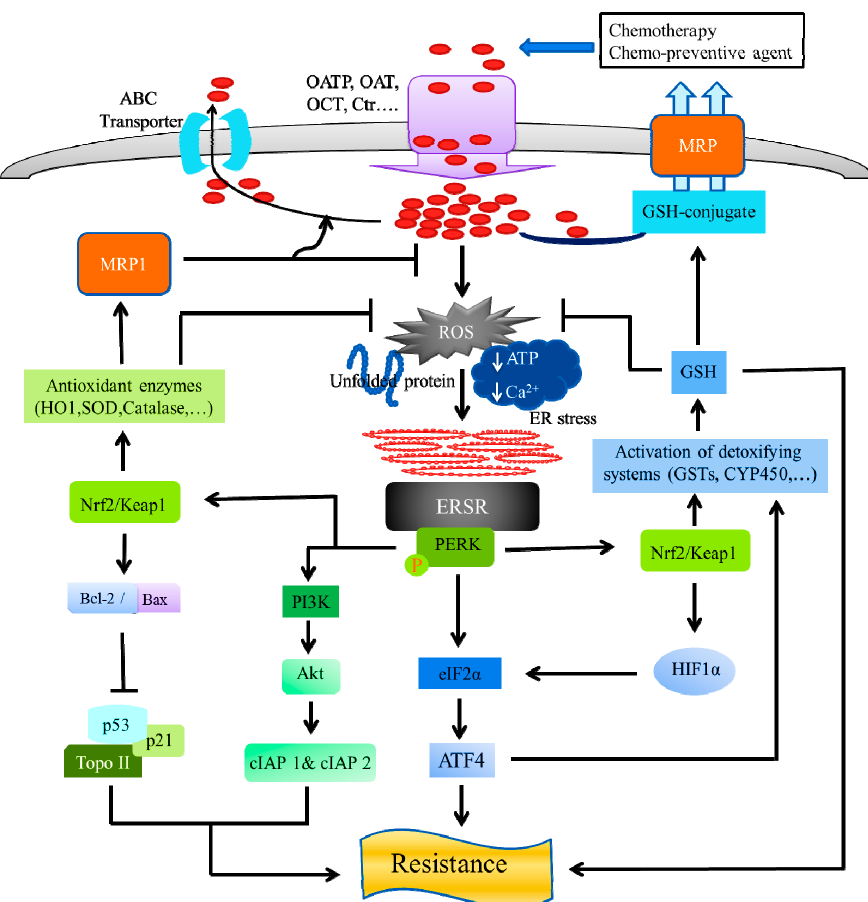
Figure 3. ER stress and chemo-resistance: Role of protein kinase R-like endoplasmic reticulum kinase (PERK). The anti-neoplastic drugs, possess ERS-mediated apoptosis and exert their anticancer effect by entering the tumor cells, using influx transporters, including an organic anion transporter (OAT), organic anion-transporting polypeptide (OATP), organic cation transporter (OCT), and a copper transporter (Ctr). On the other hand, ATP-dependent multidrug transporters of the carrier-mediated, ubiquitous superfamily of ATP-binding cassette (ABC) proteins actively efflux chemotherapeutic agents out of the cell. ABC proteins include the multidrug resistance protein (MDR), which confer resistance to many anticancer drugs in cancer cells. The ERS-mediated activated PERK, phosphorylates eukaryotic translation initiation factor-2 α (eIF2 α ) and nuclear factor erythroid 2 (NFE2)-related factor 2 (Nrf2). Activation of PERK via agents that trigger the ERSR, promotes a dissociation of the cytoplasmic Nrf2/Keap1, and the Nrf2 possess its cyto-protective activity by activating detoxifying enzyme systems, including the cytochrome P450 (CYP) system, glutathione-S-transferases (GSTs), thus, reducing ROS, leading to the prevention of apoptosis in cancer cells. The GSTs ensure a high GSH concentration and GSH-transporters inside cancer cells, which are associated with a high resistance to chemotherapeutic agents. The GSH exhibits cancer cell resistance to anti-neoplastic treatments, either by inhibition of apoptosis or chemotherapeutic drug detoxification, by the GSH-drug conjugation, followed by efflux through the GSH-pump of MRP transporters. The activated PERK-Nrf2 signaling, upregulates the multidrug resistance protein 1 (MRP1), by the activation of antioxidant enzymes (HO-1, SOD, catalase, etc.) that neutralize the reactive oxygen species (ROS) and increases the drug efflux, leading to a reduction in the ROS levels. Nrf2 stabilization by the exposure of antioxidant enzymes, leads to an increased Bcl-2/Bax ratio, subsequently reducing apoptosis and increasing cell survival, by regulation of Topo II, p53, and its target gene p21. The PERK activity can induce cellular inhibitor of apoptosis (cIAP1 and cIAP2) proteins, by the activation of phosphatidylinositol 3-kinase (PI3K)-Akt signaling pathway, leading to chemotherapy